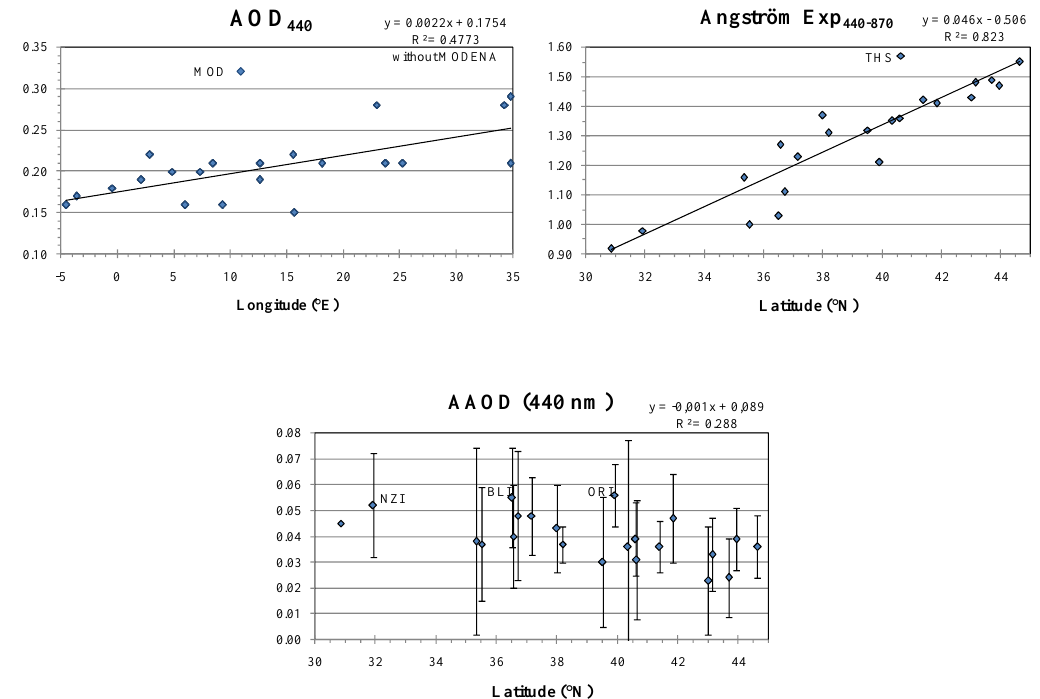
Fig. 3. AERONET level-2 average AOD as a function of station longitude and average AE and AAOD as a function of station latitude. Other data given in Table 2 are less or not significantly correlated with latitude or longitude with the exception of the real part of RI at 440 and 670nm and the imaginary part of RI at 670nm (not shown) that also correlate with latitude at the 0.01 level ( R 2 >0.288 for 20 degrees of